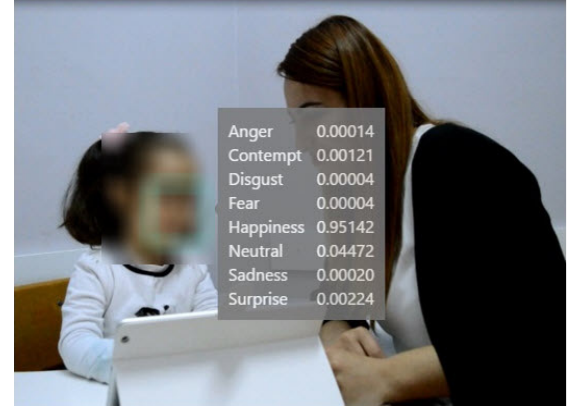
Figure 4. Student 2’s emotional analysis results.